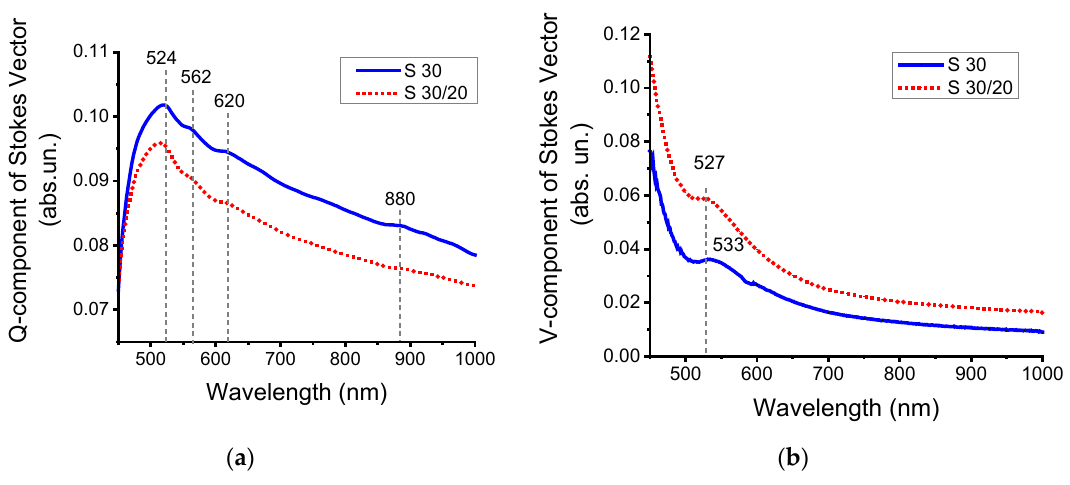
Figure 8. The modulation polarimetry spectra for samples S30 and S30/20 : ( a ) amplitude and ( b ) phase anisotropy.